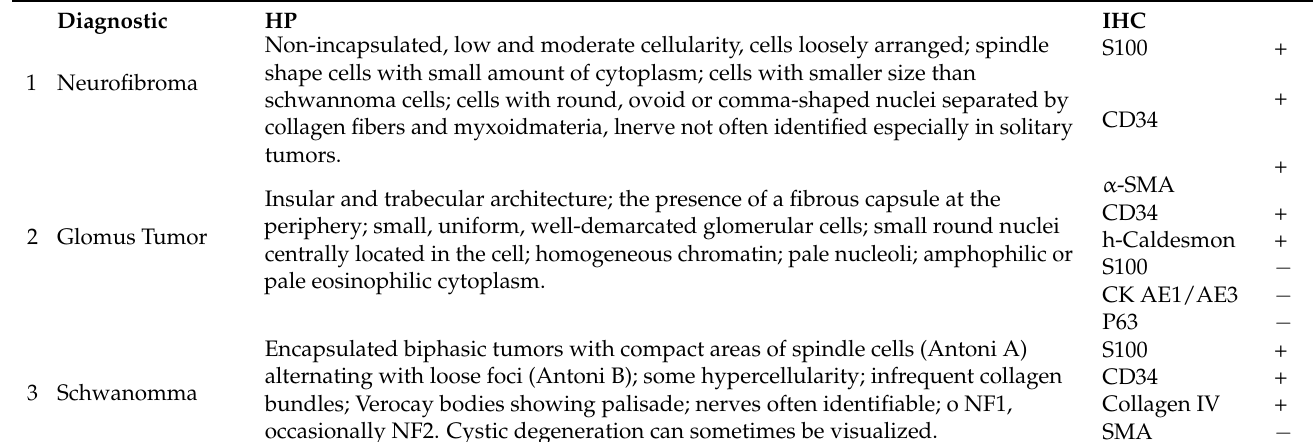
Table 4. Histopathological and immunohistochemical features of the tumors in the study